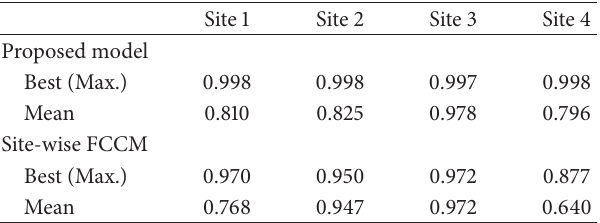
Table 2: Comparison of partition quality measured by correlation coefficients among item memberships (heterogeneous partition case).